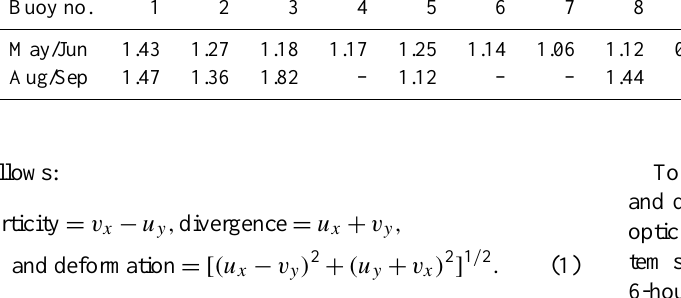
Table 2. Monthly averages of U i / U g in % and difference angle α i – α g in four regions of the transpolar ice drift based on data from the D07 array and the PAWS buoys G and I. Month J F M A M J J A S O N D Source Siberia 1.15 0.95 0.80 1.12 1.45 1.20 1.10 I 1 ◦ − 2 ◦ − 3 ◦ 4 ◦ 10 ◦ 5 ◦ 2 ◦ North Pole 1.04 1.08 1.58 1.45 Array, 14 ◦ 17 ◦ 17 ◦ 18 ◦ ? G, I Greenland 0.85 Fram Strait 1.80 10 ◦